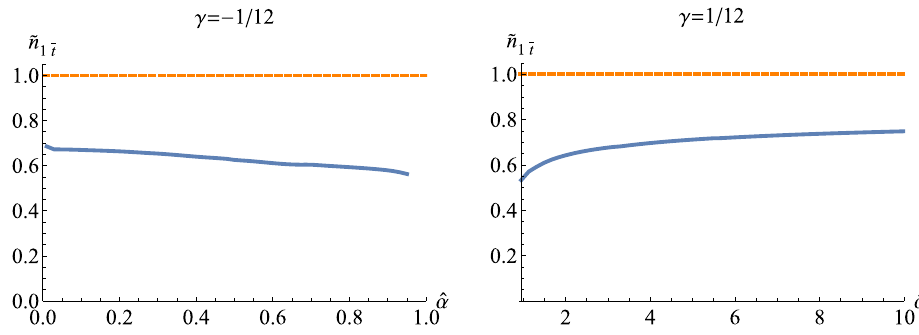
Fig. 15 The shape of the potentials V 1 ¯ t with γ = − 1 / 12 (left plots) and γ = 1 / 12 (right plots) for various value of ˆ α is shown. (For interpretation of the references to color in this figure, the reader is referred to the web version of this paper)